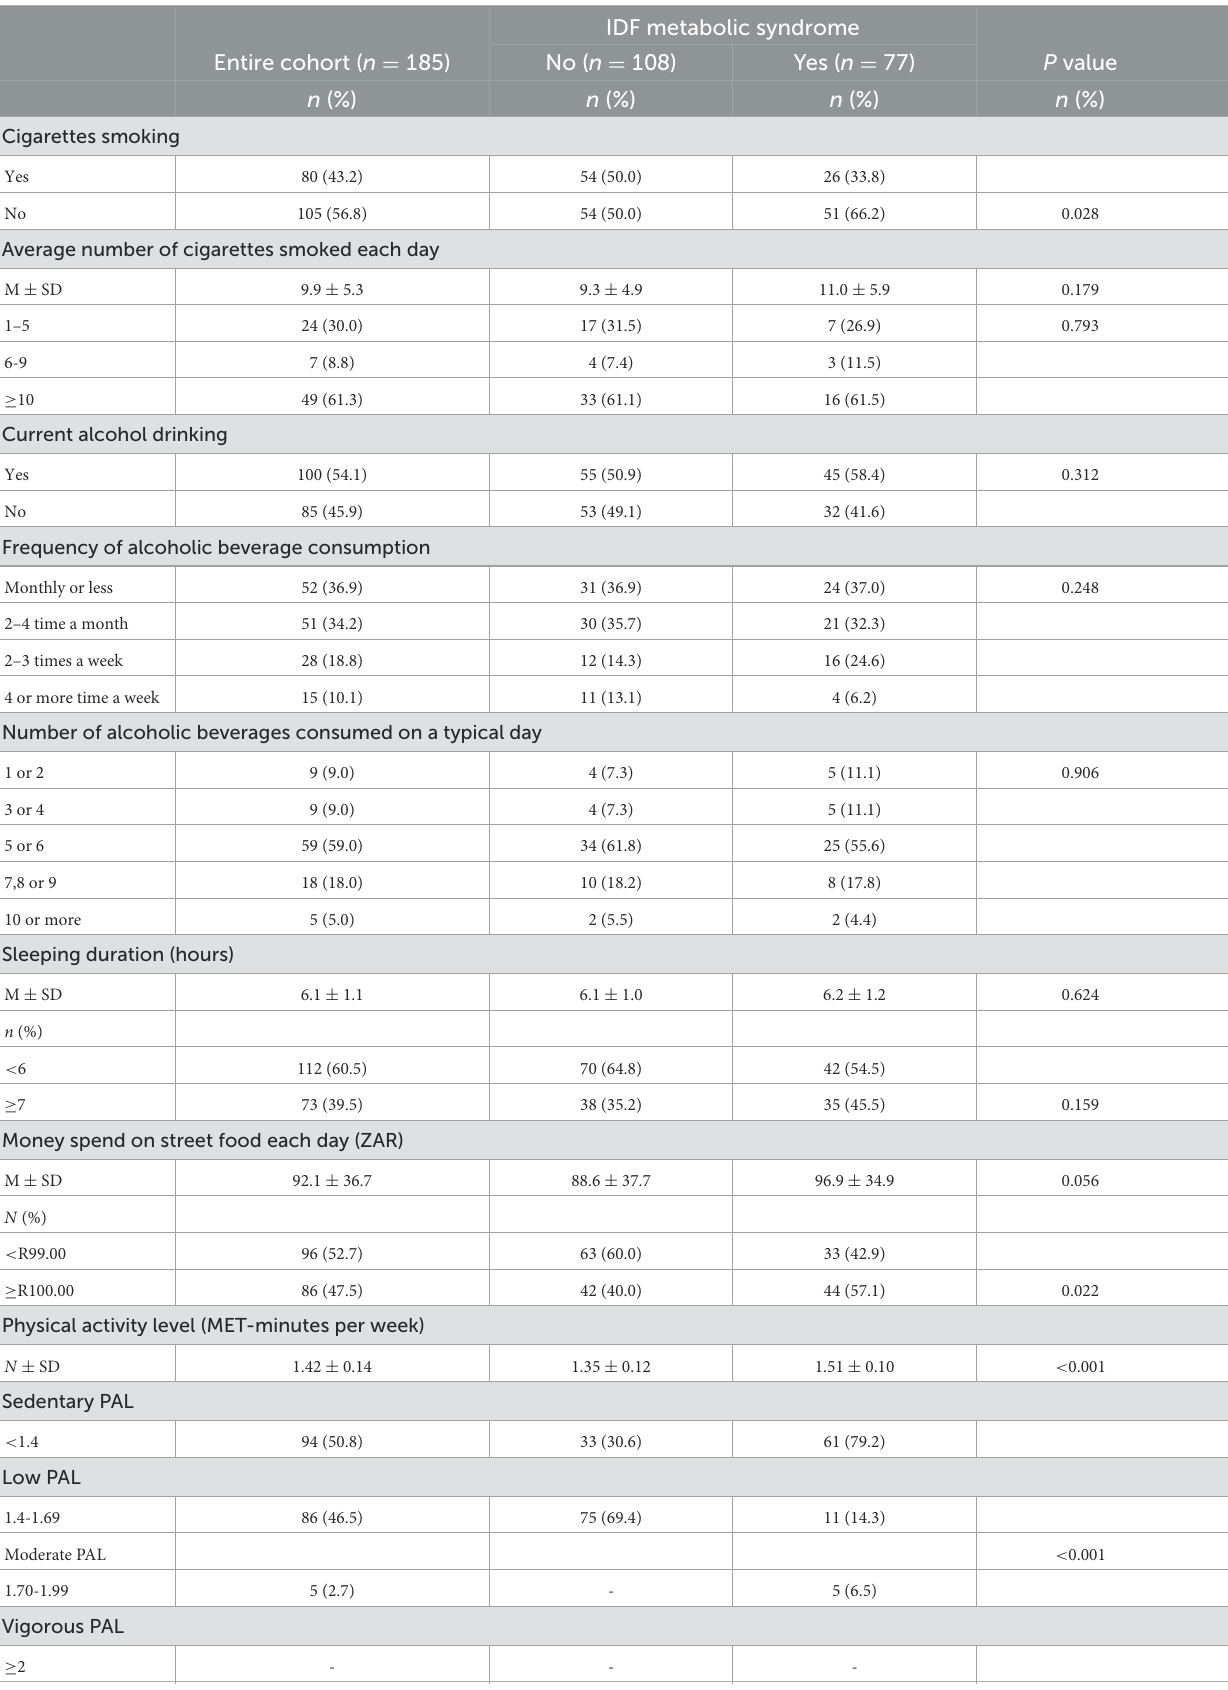
TABLE 5 The distribution of the South African minibus taxi drivers by their lifestyle risk factors (i.e., cigarettes smoking, alcohol consumption, physical activity level, sleep duration and money spent on street food each day) and MetS. IDF metabolic